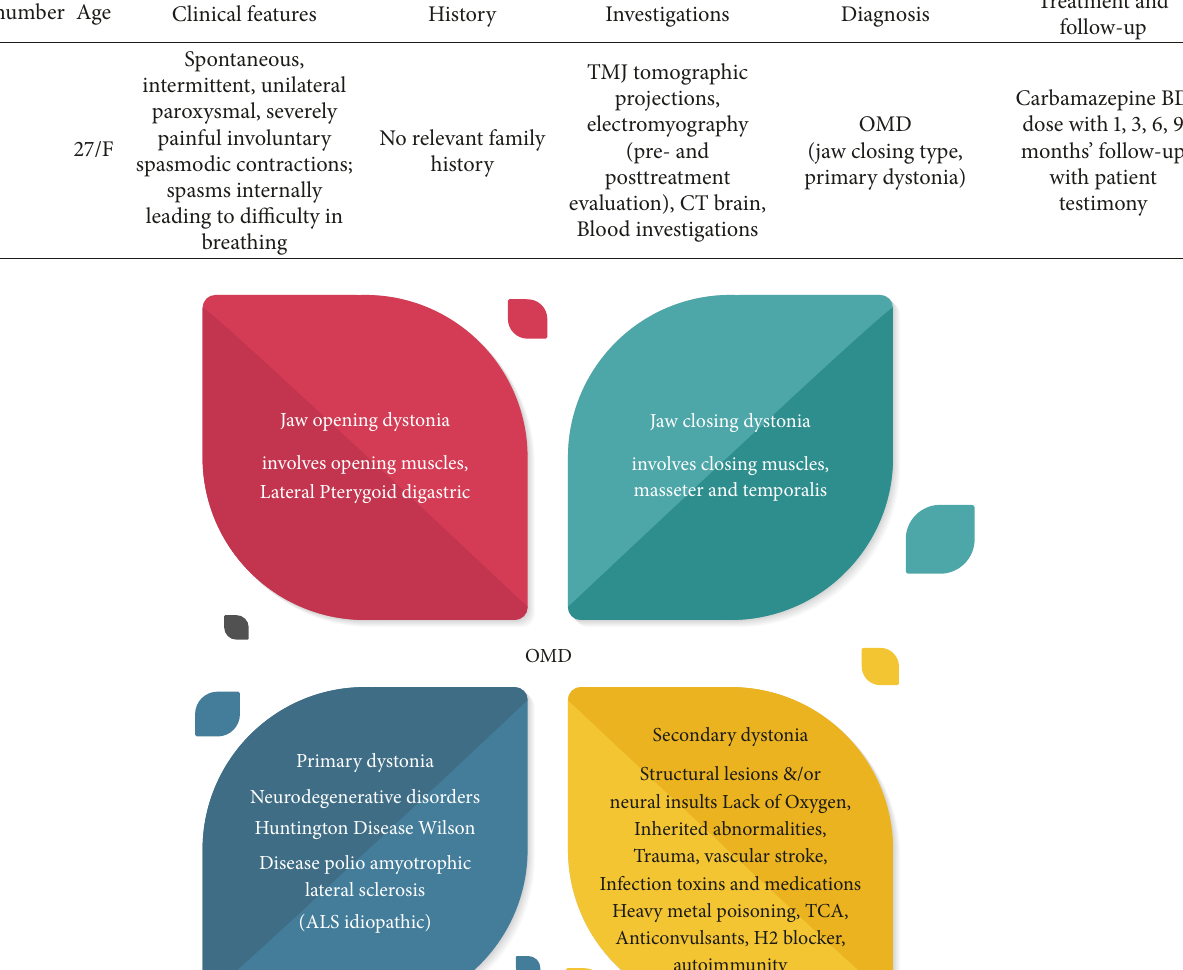
Table 1: Clinical features and investigations in the diagnostic work-up of the case. Sl. number Age